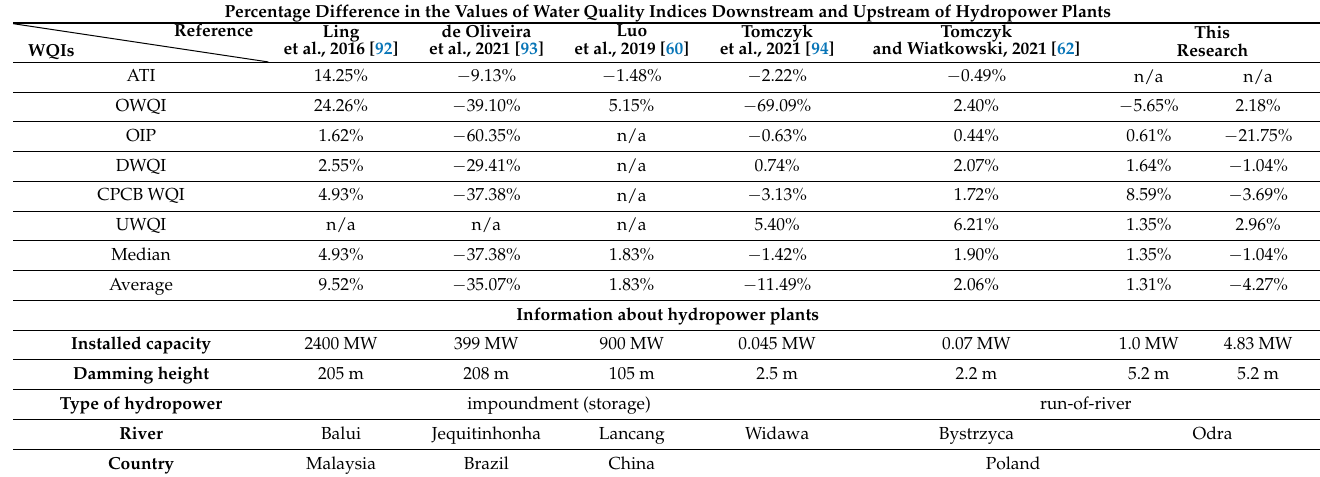
Table 16. Comparison of water quality indices (WQIs) results within selected hydropower